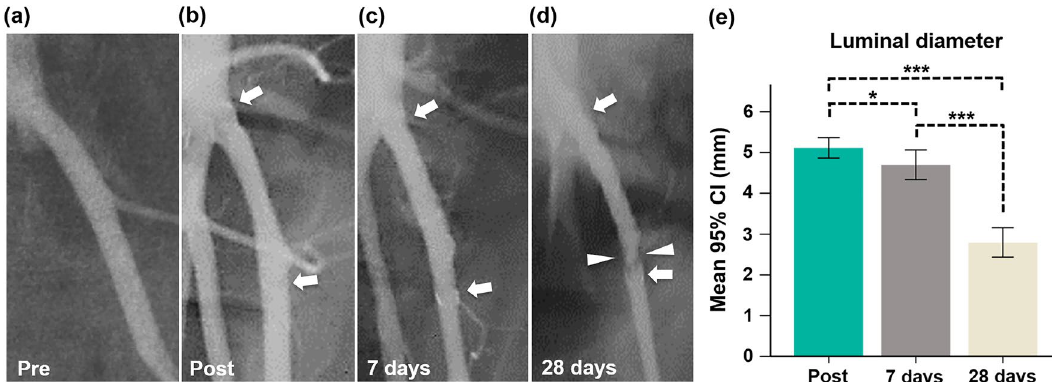
Figure 2. Representative follow-up angiographies with the mean luminal diameters in the stented LIAs. ( a ) Pre- angiography shows the LIA. ( b ) Post-angiography shows the fully expanded TPU and GL blended NFs-covered stent-graft (arrows). ( c ) Follow-up angiography at 7 days shows good patency of the stent-graft (arrows). ( d ) Follow-up angiography at 28 days shows an irregular luminal narrowing (arrowheads) at the distal portion of the TPU and GL blended NFs-covered stent-graft (arrows). ( e ) The graph shows changes in the luminal diameters in the stented LIAs. Note. CI, confidence interval; Note. TPU: thermoplastic polyurethane, GL: